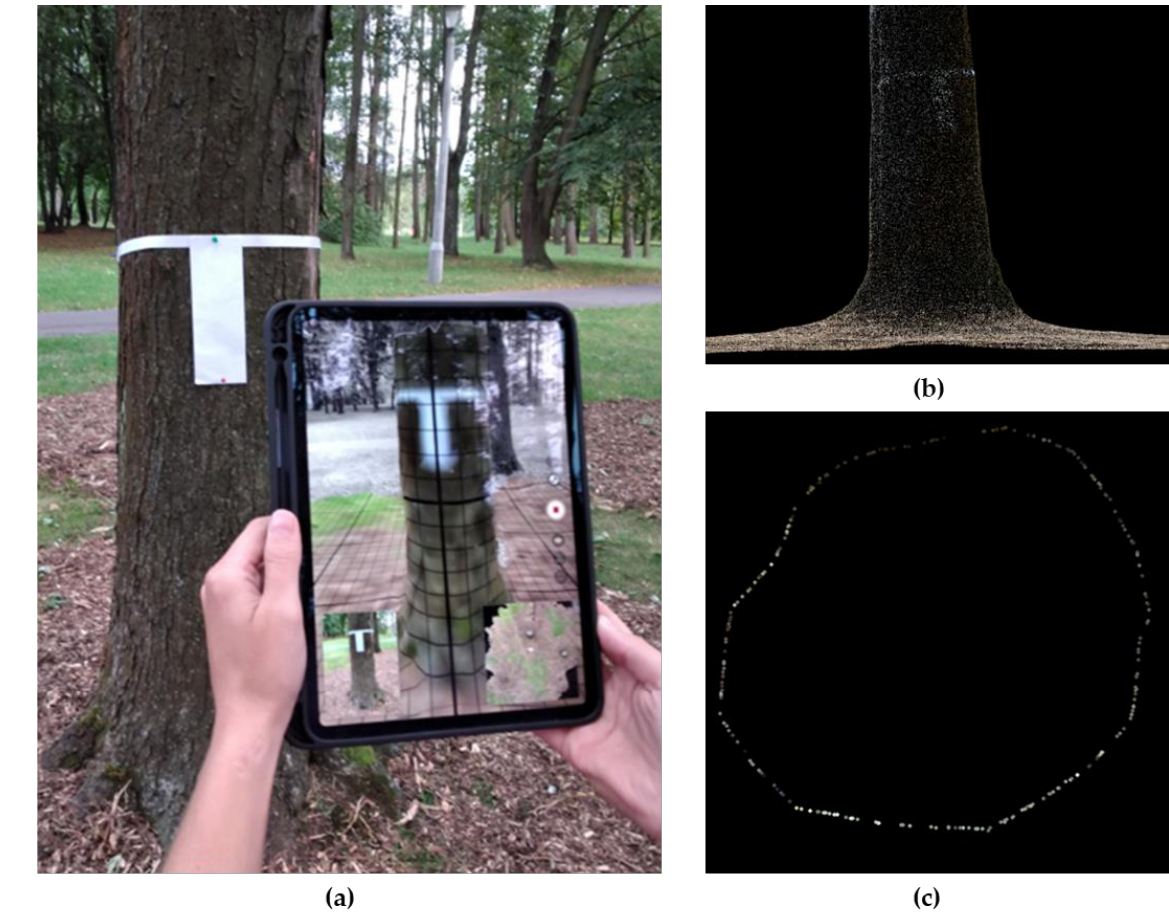
Figure 3. The 3D data acquisition using the iPad Pro (Apple) of an Acer saccharinum tree: ( a ) the texturized 3D image; ( b ) the 3D point cloud profile of the tree scanned; ( c ) the slice of point cloud at the PBH position.